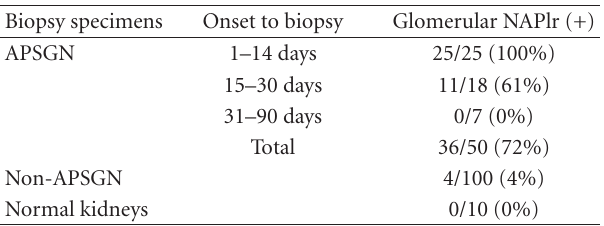
Table 2: Glomerular NAPlr deposition in APSGN, non-APSGN, and normal kidney